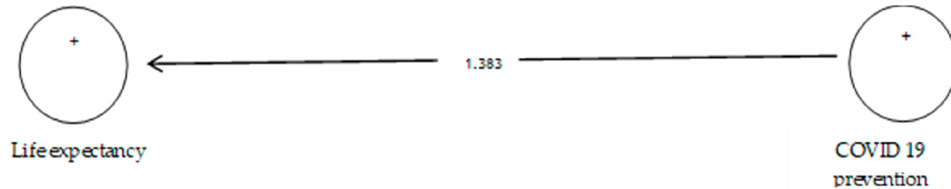
Figure 7. Drawn model with significant coefficients z. Table 6. Evaluation indicators of the internal model of the research, direction and significance of direct effects.